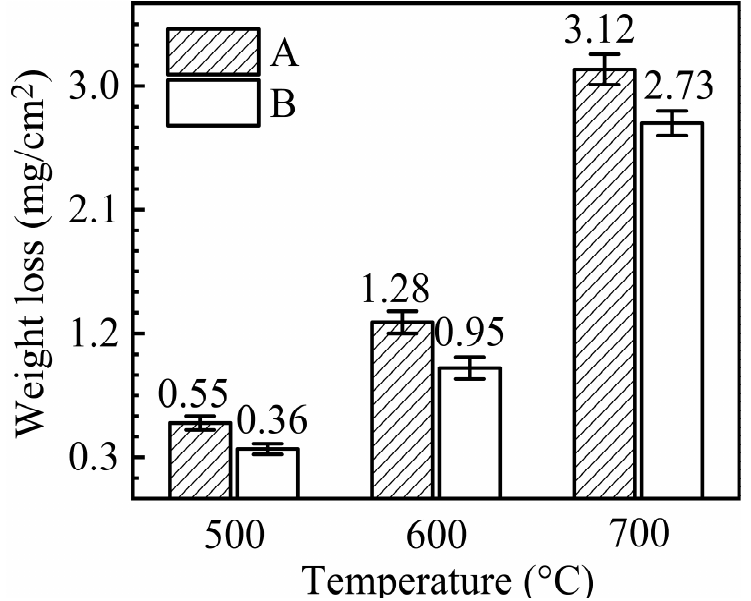
Figure 2. Weight changes of 316SS alloys immersed in salts A and B at 500, 600, and 700 °C under Ar for 100 h.